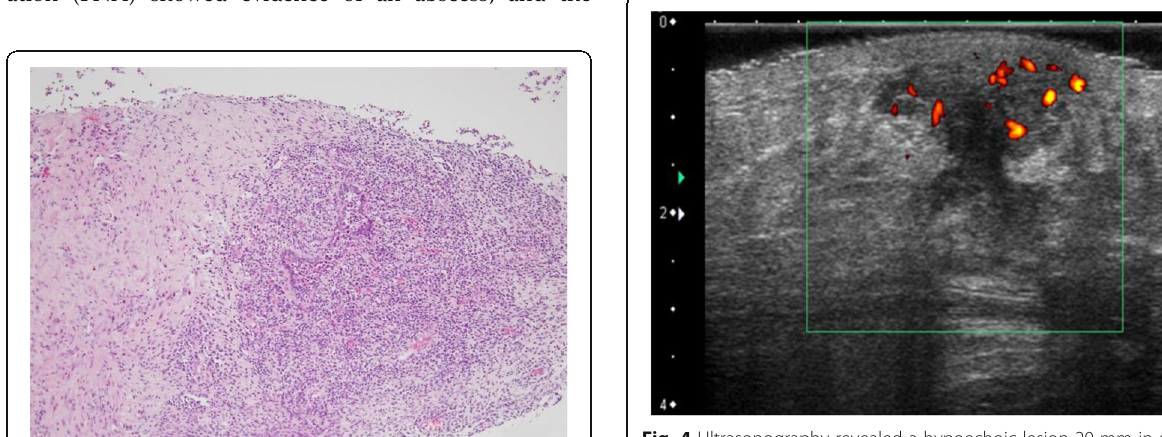
Fig. 4 Ultrasonography revealed a hypoechoic lesion 20 mm in size, with border irregularity and blood flow, initially diagnosed malignancy